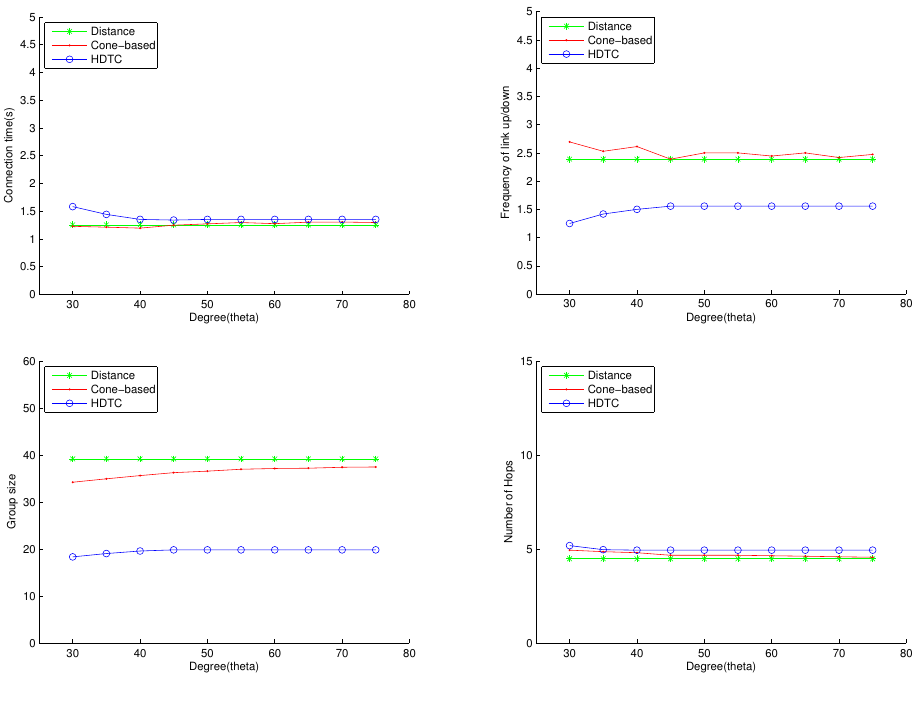
Figure 19. Scenario 3: The connection time, the frequency of the link up/down, the group size and the number of hops with varying θ